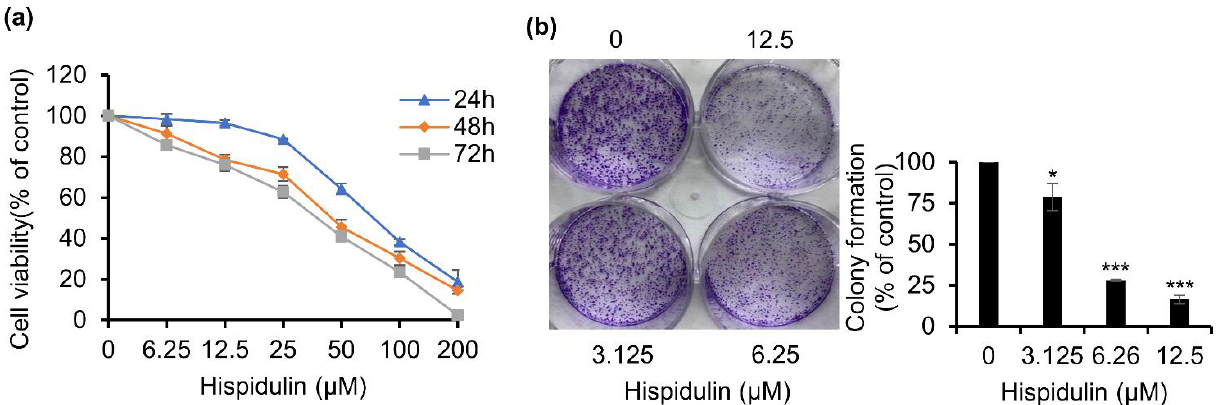
Figure 2. Anti-proliferative activities of hispidulin in CNE-2Z cells. ( a ) Effects of hispidulin on CNE-2Z cell viability for 24, 48, and 72 h by MTT assays. ( b ) Effects of hispidulin on the proliferative ability of CNE-2Z cells by colony-formation for 7 days. * p < 0.05, *** p < 0.001 vs. control.